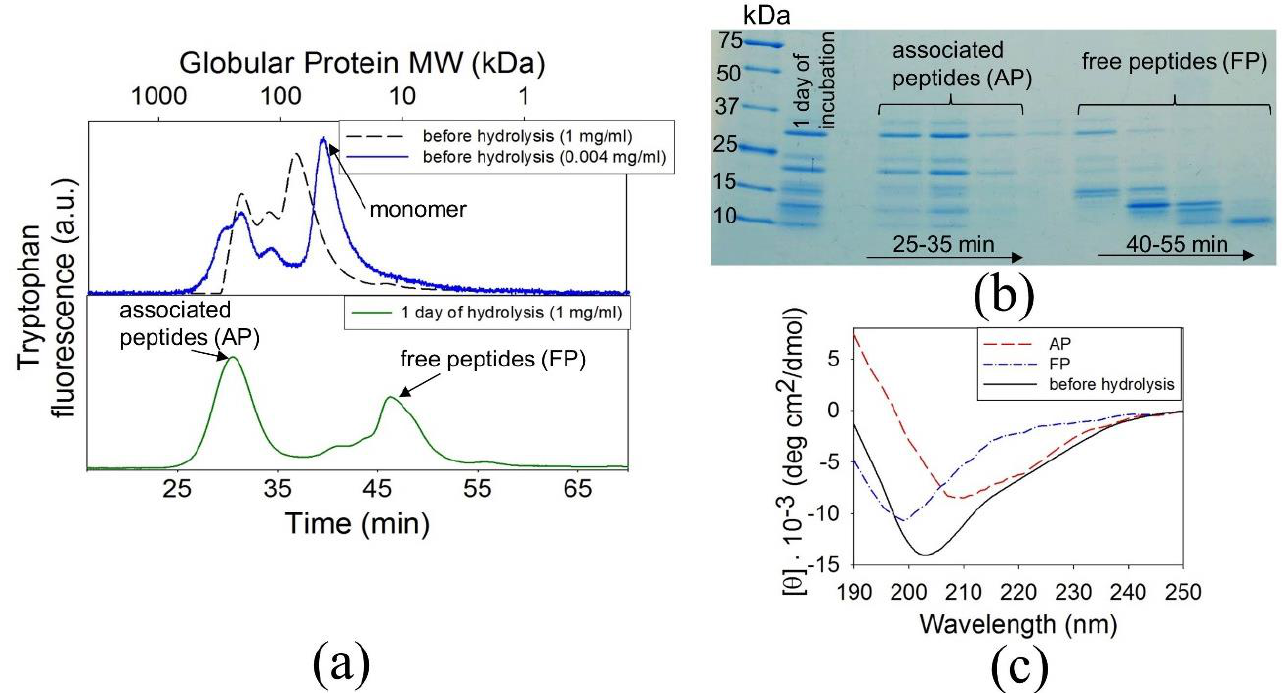
Figure 3. Size-exclusion chromatography of BCAB at pH 2.7 before (upper panel) and after 1-day hydrolysis (lower panel) ( a ). SDS-PAGE electrophoregram of chromatographic fractions of the sample after 1-day hydrolysis ( b ). Far UV CD spectra of BCAB before hydrolysis at pH 2.7, associated peptides (AP) and free peptides (FP) ( c ).